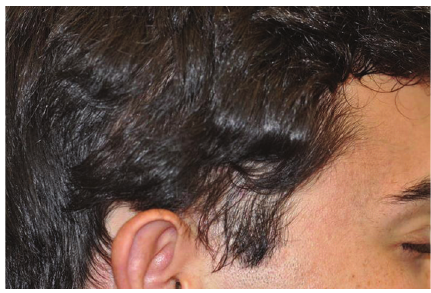
Figure 8: Right side after hair transplant.